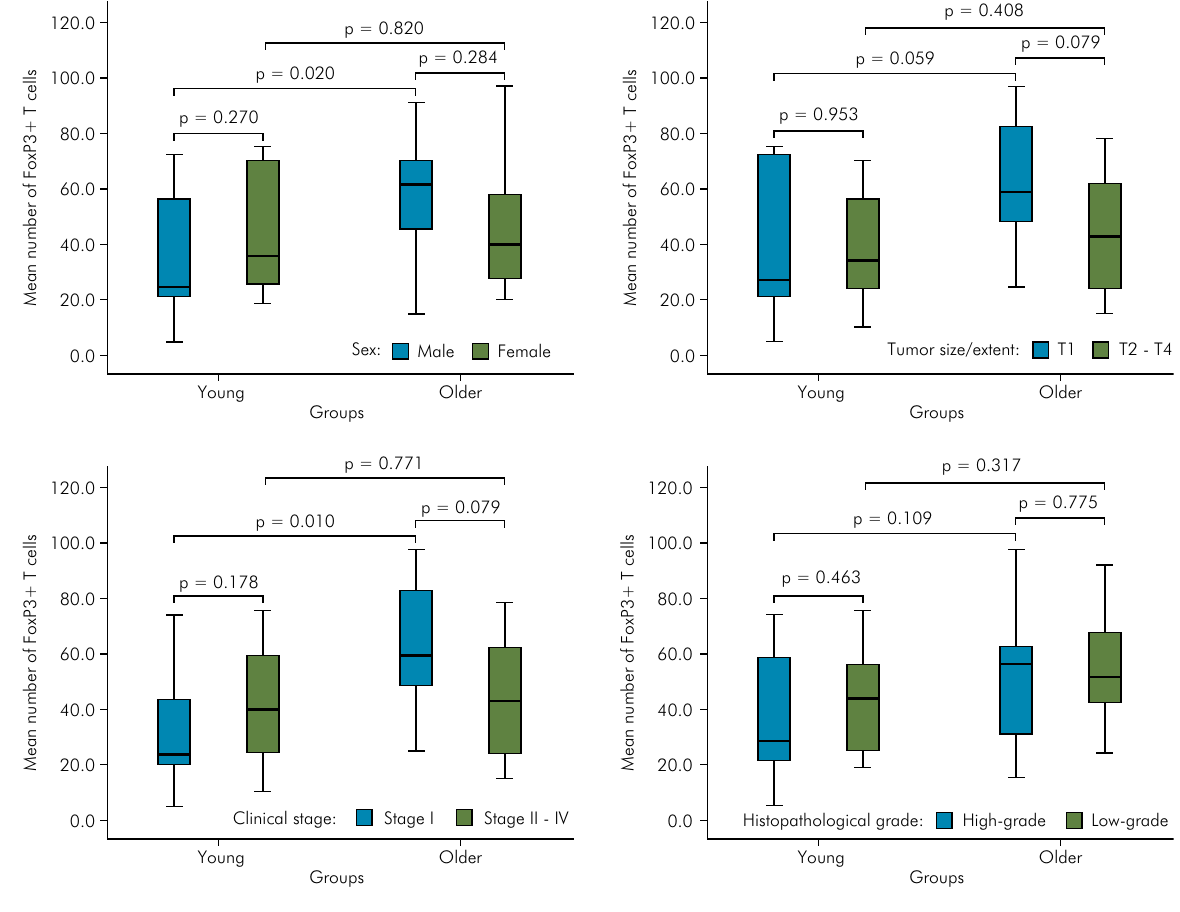
Figure 2. Box plot charts illustrating the number of FoxP3+ lymphocytes in OTSCC in young (≤ 45 years) and older (≥ 60 years) patients according to sex, tumor size, clinical stage, and histopathological grade of